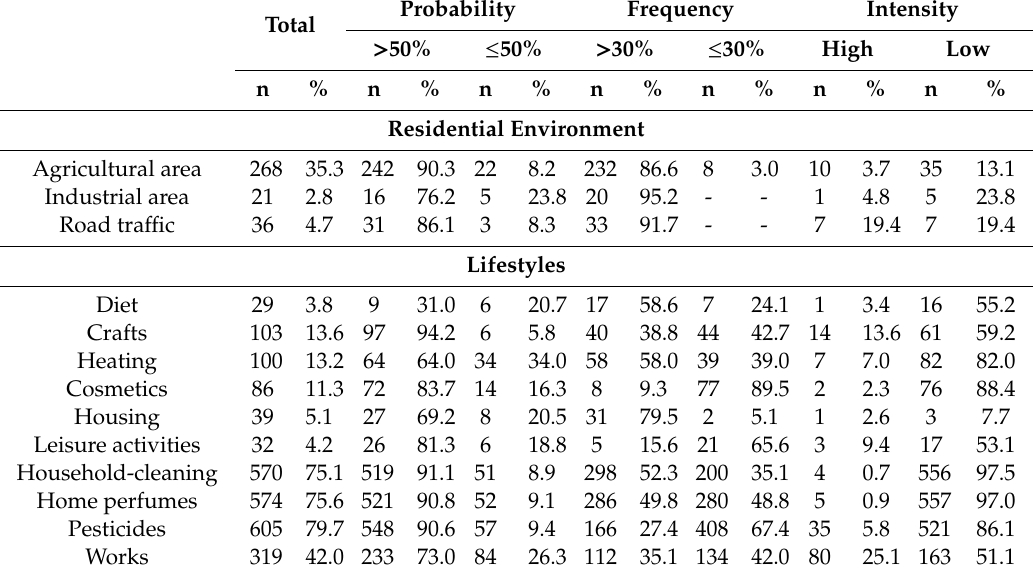
Table 6. Nonprofessional exposure reported on the day of consultation of patients seen for fertility disorders at the ARTEMIS Center from 16 February 2016 to 2 May 2019 (n = 302).